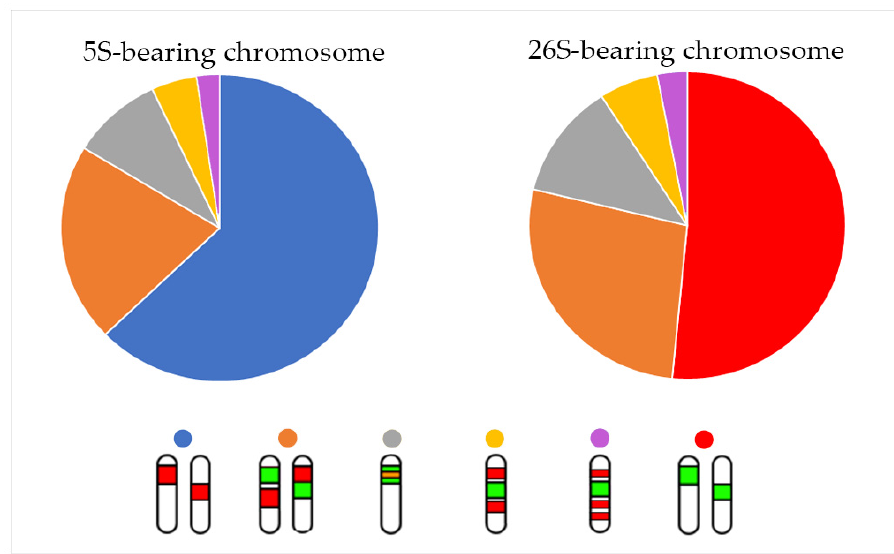
Figure 2. Distribution of described chromosomes bearing 5S (red) and 26S (green) rDNA sites and their arrangement in analysed species. Note that ideograms illustrate numbers of 5S and 26S rDNA loci and their mutual localizations only schematically and do not precisely capture specific chromosomal localization of each locus.